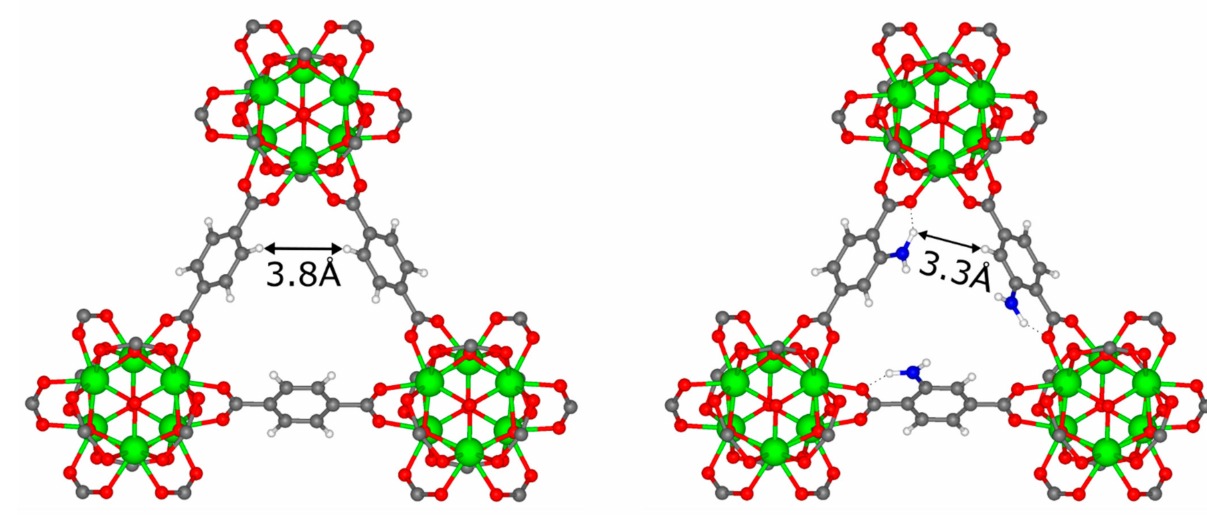
Figure 7. Pore structures of UiO-66 and UiO-66-NH 2 .